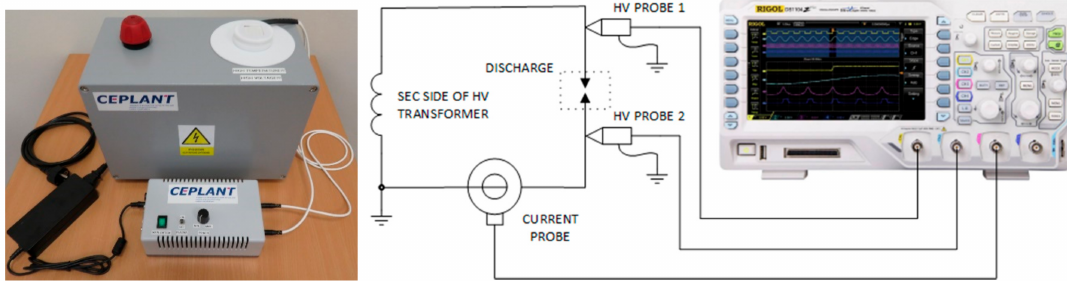
Figure 6. The photograph of the device for plasma-activated water vapor (PAWV)/plasma-activated water aerosol (PAWA) generation and electrical measurement schematics.